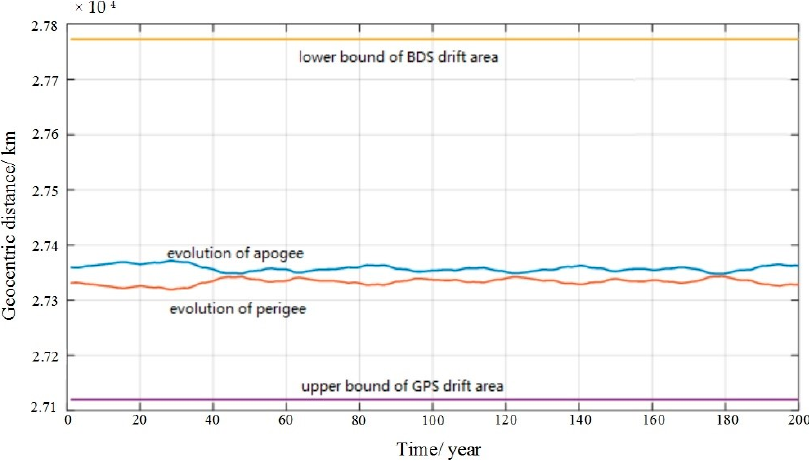
Figure 22. Variations in the minimum perigee and the maximum apogee of the optimal disposal orbit.